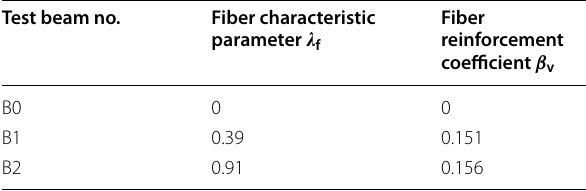
Table 6 Fiber characteristic parameter and fiber-reinforcement coefficient of test